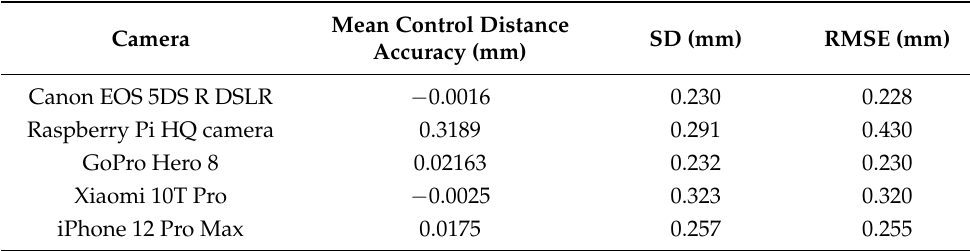
Table 4. The difference between measured and calculated marker spacing in 3D models produced using each